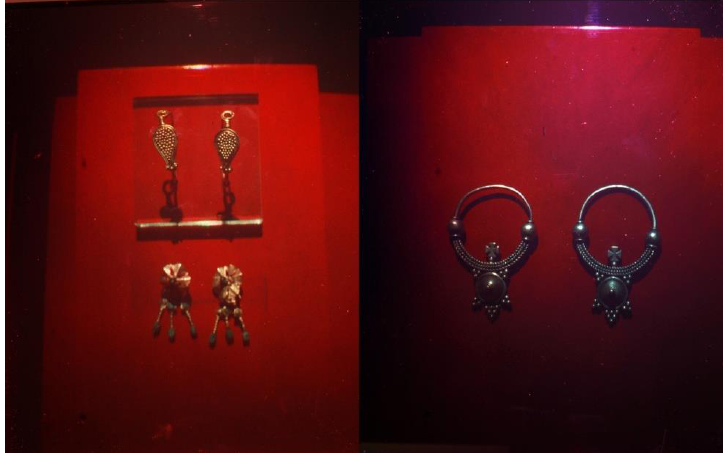
Figure 7. Left: Photograph of the OptoClone-BXM1, two pairs of golden earrings, 4th c AD ( © 2013 HiH). Right: Photograph of the OptoClone-BXM6, silver earrings, 4th c. AD ( © 2013 HiH). The OptoClone-BXM7 depicts both the front and back faces of the object in a side by side double exposure on the same plate. The OptoClones TM (BXM1 to BXM6) were displayed in place of the original objects for the period that the original objects were on loan.